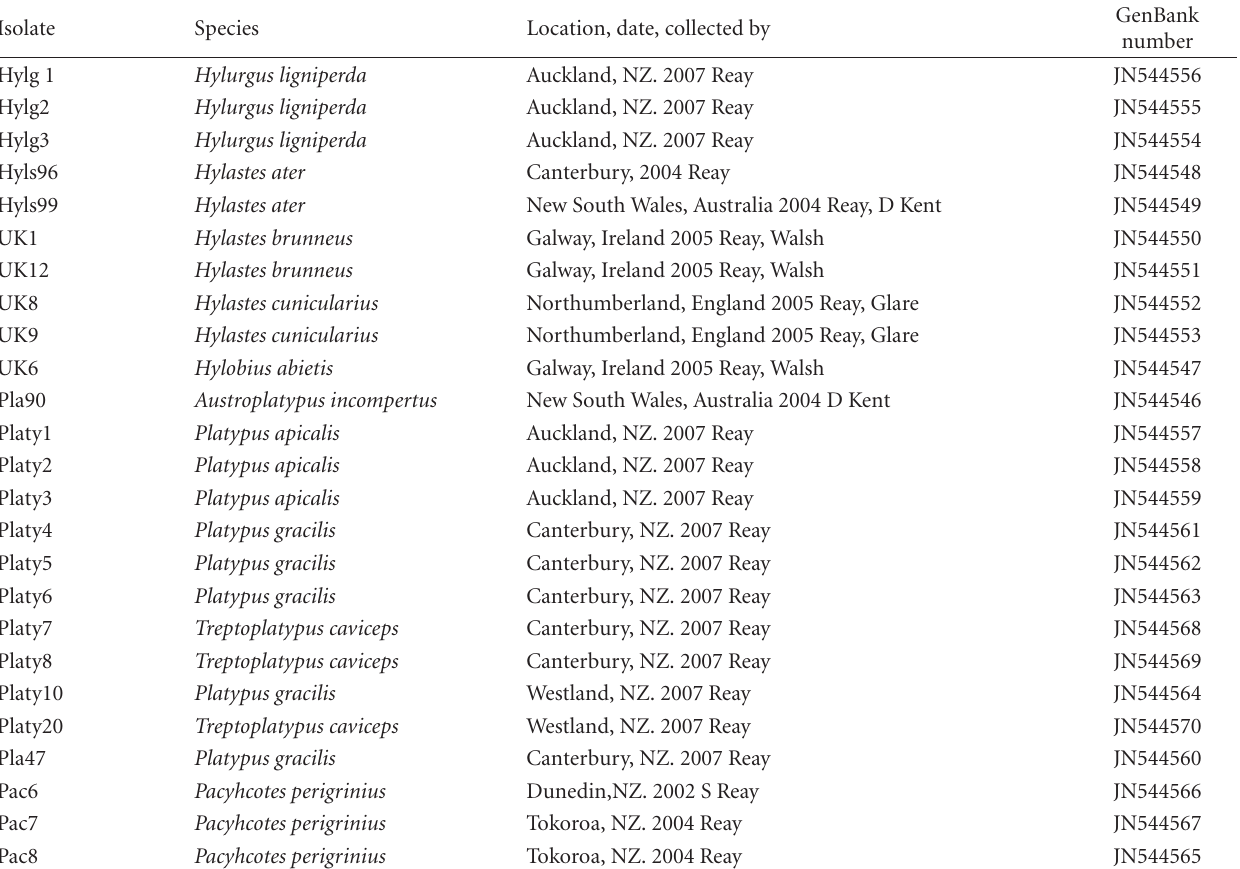
Table 1: Beetle isolates and GenBank sequence data used in this